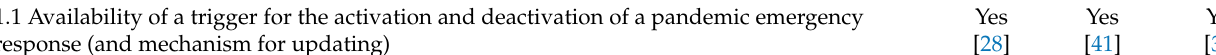
Table 3. Pillar 1: National coordination, planning, and monitoring.